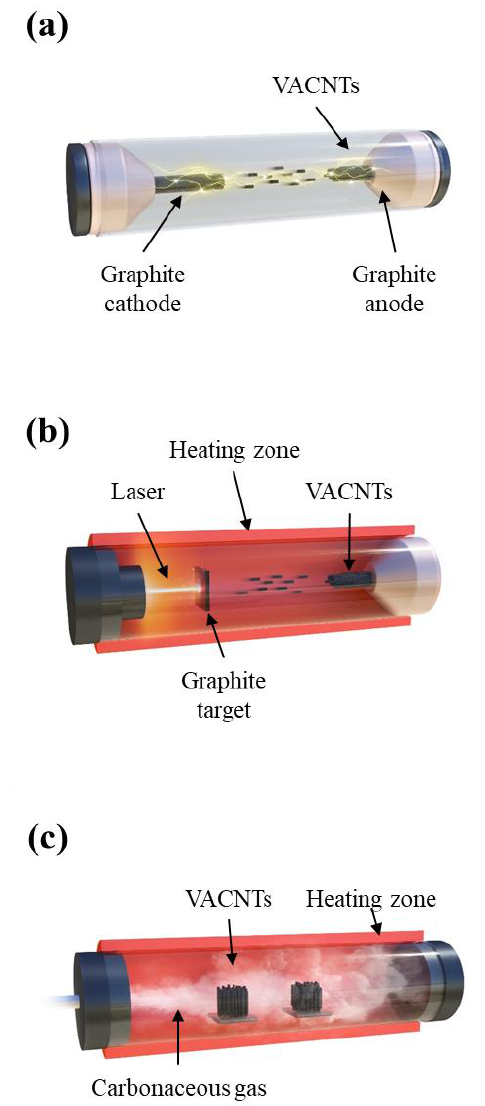
Figure 2. Three major methods to synthesize vertically-aligned carbon nanotubes (VACNT): ( a ) arc discharge, ( b ) laser ablation, and ( c ) chemical vapor deposition (CVD).